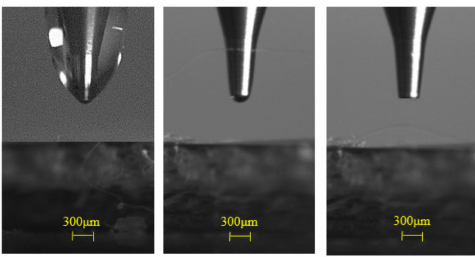
Figure 5. Morphology of wax liquid at the bottom of the nozzle under different gas pressures: ( a ) fully wrapped nozzle; ( b ) meniscus shape; ( c ) no meniscus shape.